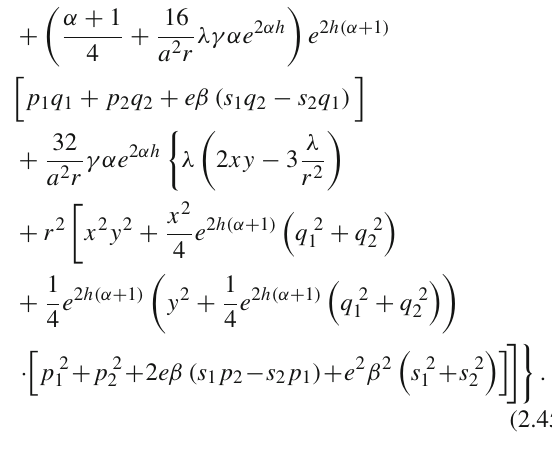
profiles (3.1) and